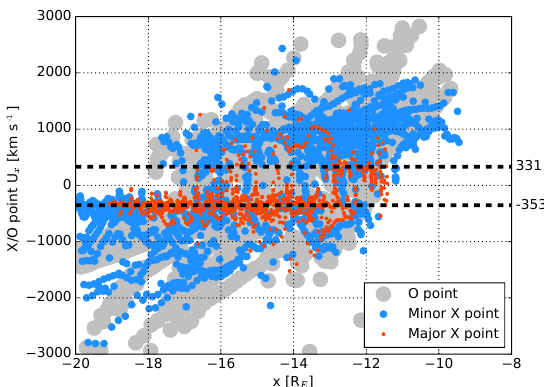
Figure 10. The expression of Eq. (3) estimated at the locations of the magnetotail plasma sheet X and O points as a function of X point velocity. The line of equality is shown in solid black and linear fits to the O point values, minor X point values, and major X point values in dashed gray, blue, and red,